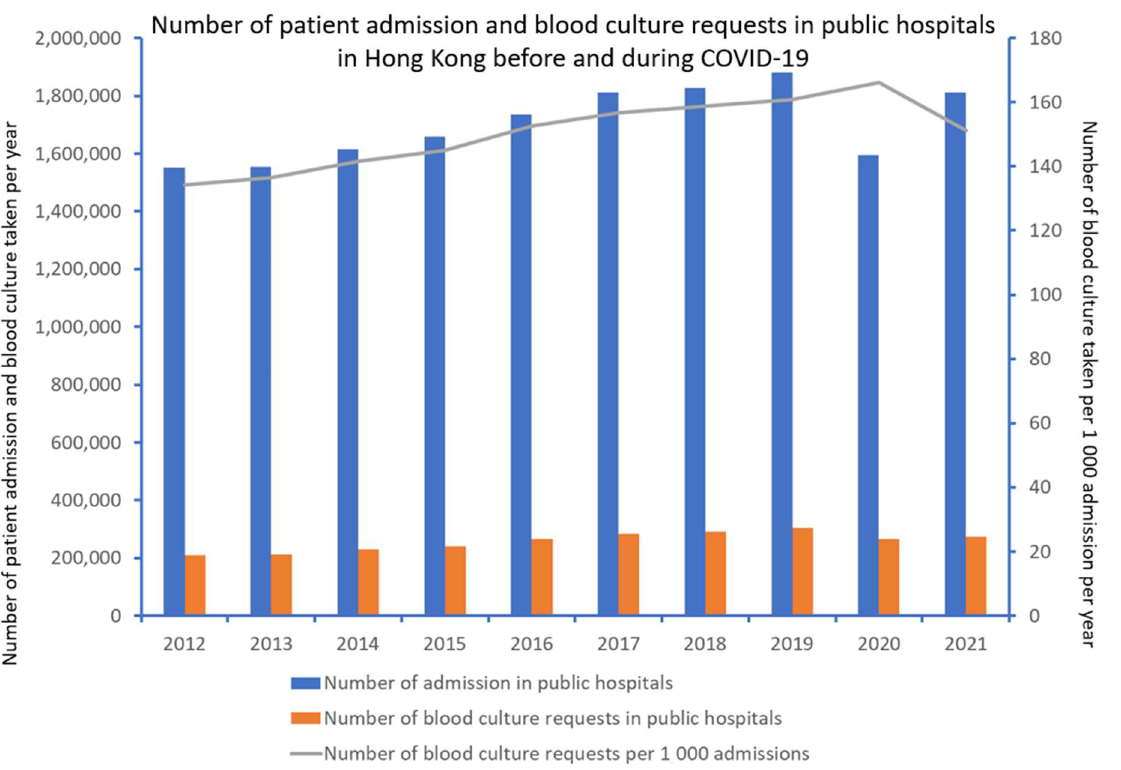
Figure 3. Number of patient admission and blood culture requests in public hospitals in Hong Kong before and during COVID-19.